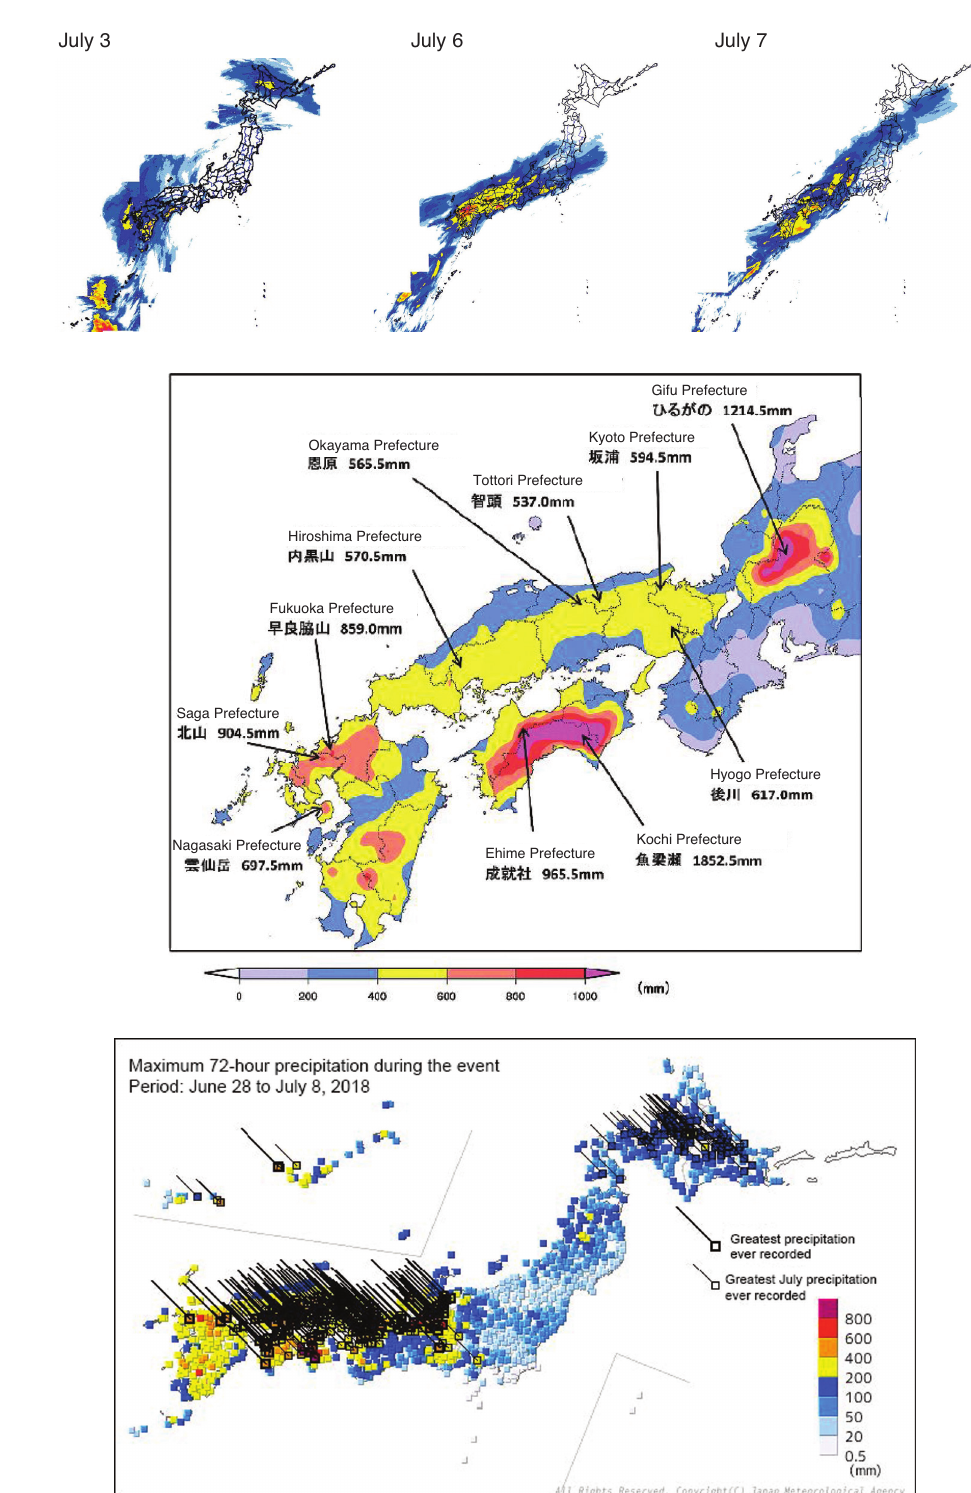
Distribution of the maximum 72-hour precipitation during the event. © 2017 Disaster Management, Cabinet